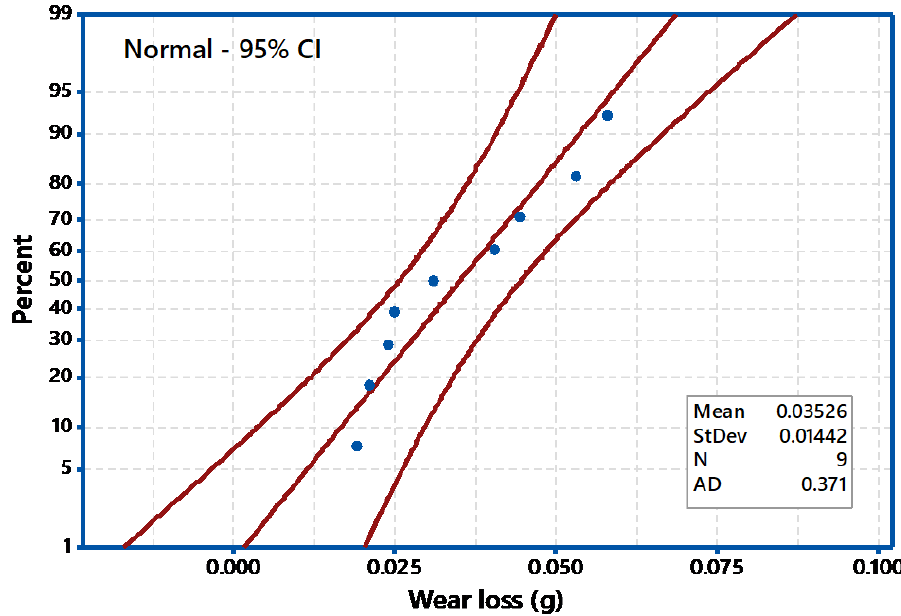
Figure 9. Probability plot for wear loss.